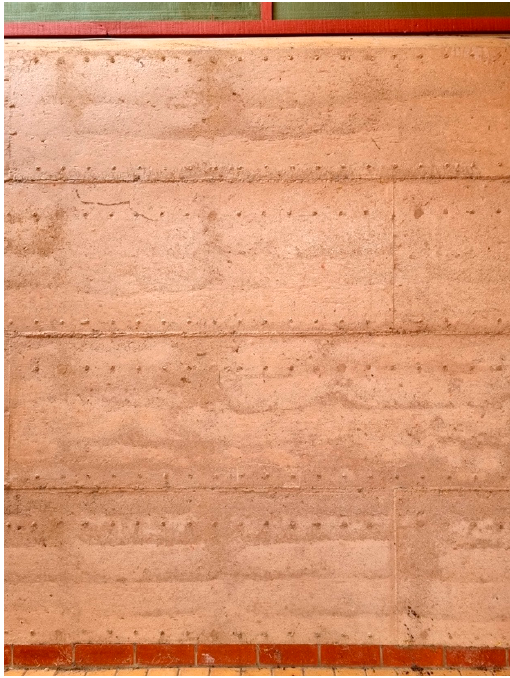
Figure 12. Section of an external wall covered by a large overhanging roof. Note the details of the recessed bolts holding the form boards as well as the sections of form boards (Bldg 762).